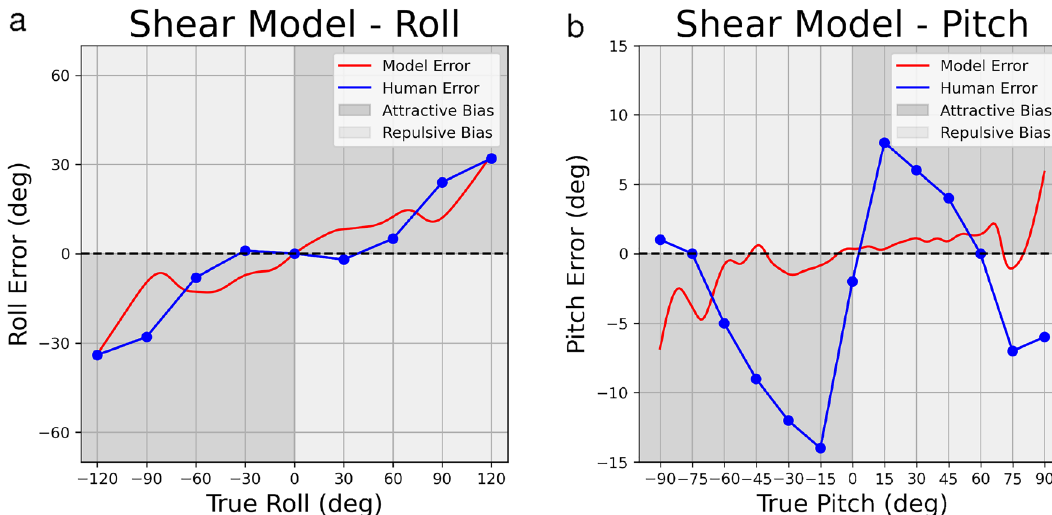
Figure 5. Utricular shear models for roll (5a) and pitch (5b). X- and Y- axes represent true orientation eccentricity and orientation eccentricity error, respectively. X-axis ticks and gridlines represent eccentricities where psychophysical data were reported in previous data, while psychophysical data between gridlines are linearly interpolated.